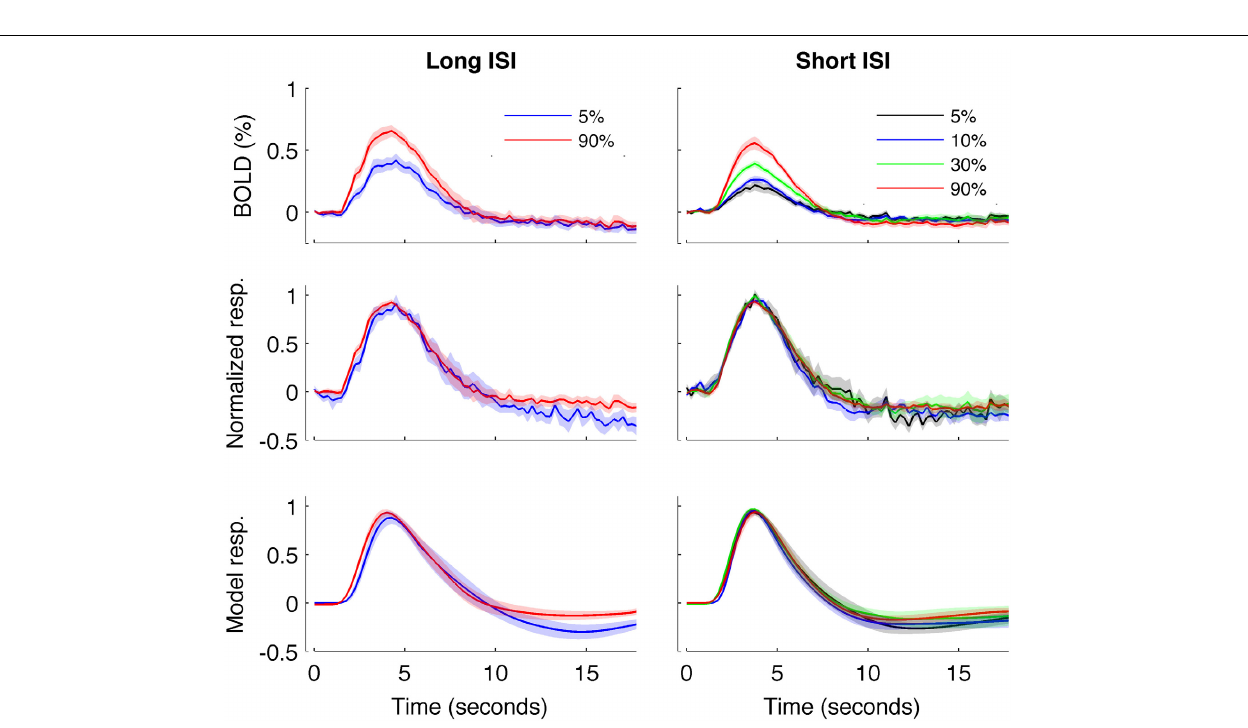
FIGURE 5 | HRFs averaged across all subjects. Left: Experiment 1 (long-ISI). Right : Experiment 2 (short-ISI). Top row : Average HRFs ( n = 8, 10 for 5 and 90% contrast in long-ISI experiment, n = 7, 10, 9, 10 for 2.5, 5, 25, and 90% contrast in short-ISI experiment). Middle row : Each HRF scaled by the peak amplitude of fit before averaging, to